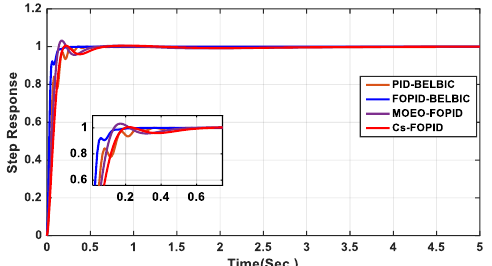
Figure 11. Comparison of unit step response of AVR system with different controllers.